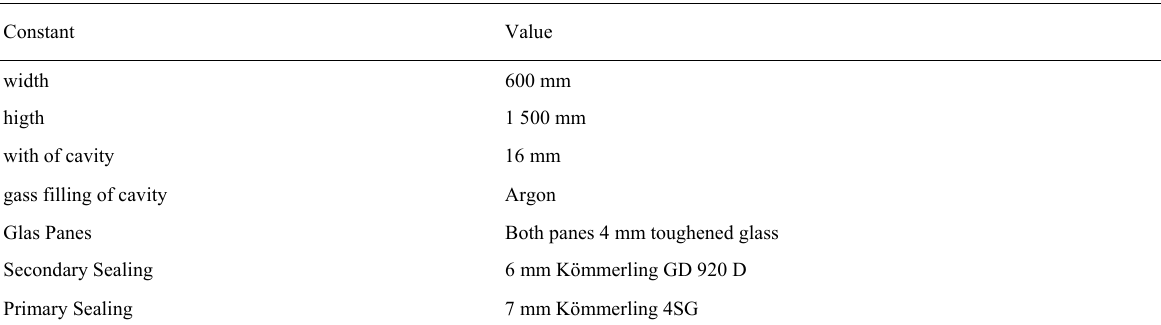
Table 3: Technical data of the IGUs used for the 1-axial bending tests